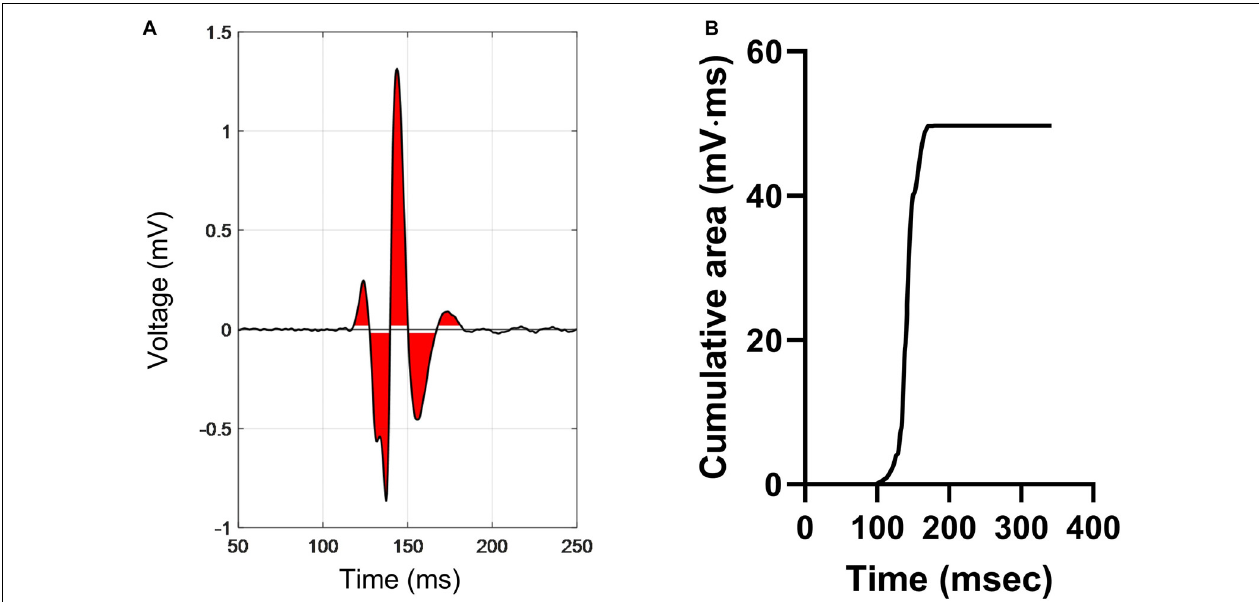
FIGURE 2 | Calculation of electrogram area in a bipolar electrogram recording. (A) A representative bipolar electrogram recording. Signals above and below a noise threshold of ± 0.05 mV are shaded in red. (B) Graph showing the cumulative sum of the shaded area, where the peak value is the total electrogram area. Normalized electrogram area is calculated by dividing the total area by the signal amplitude